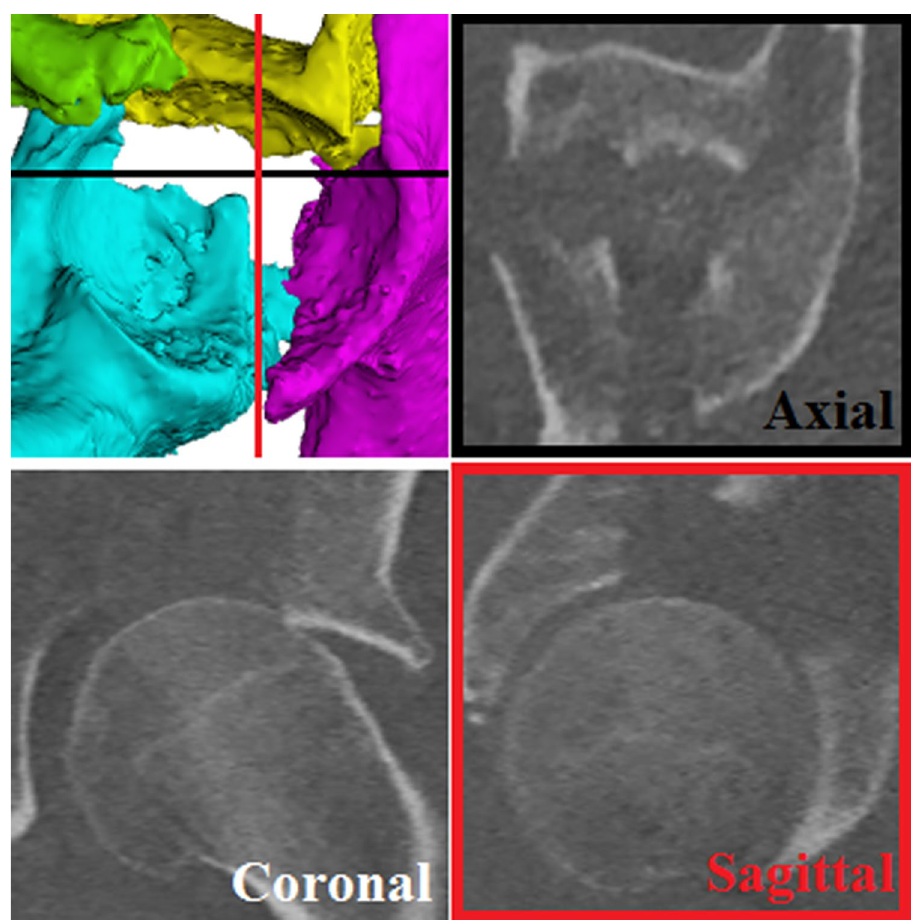
Figure 4. A gap and step-off can be seen on a 3D view of the acetabulum (top left). The black line represents the axial plane and the red line represents the sagittal plane. Multiple fracture lines, with gaps and step-offs, can be seen on the CT